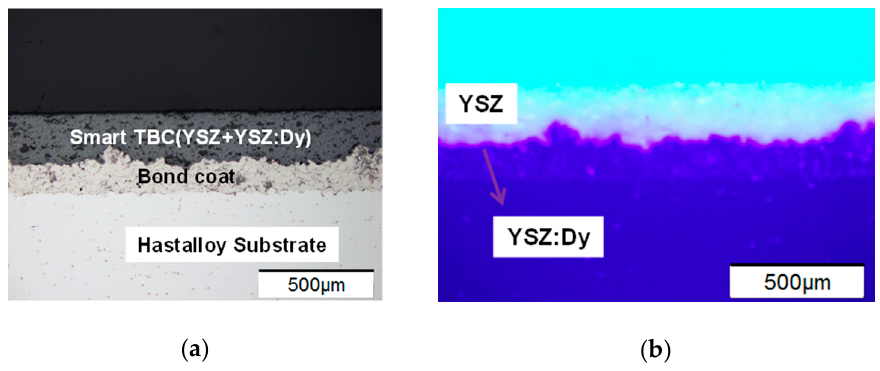
Figure 1. Microstructure of phosphor-doped TBC: ( a ) no excitation and ( b ) excited by UV-LED.